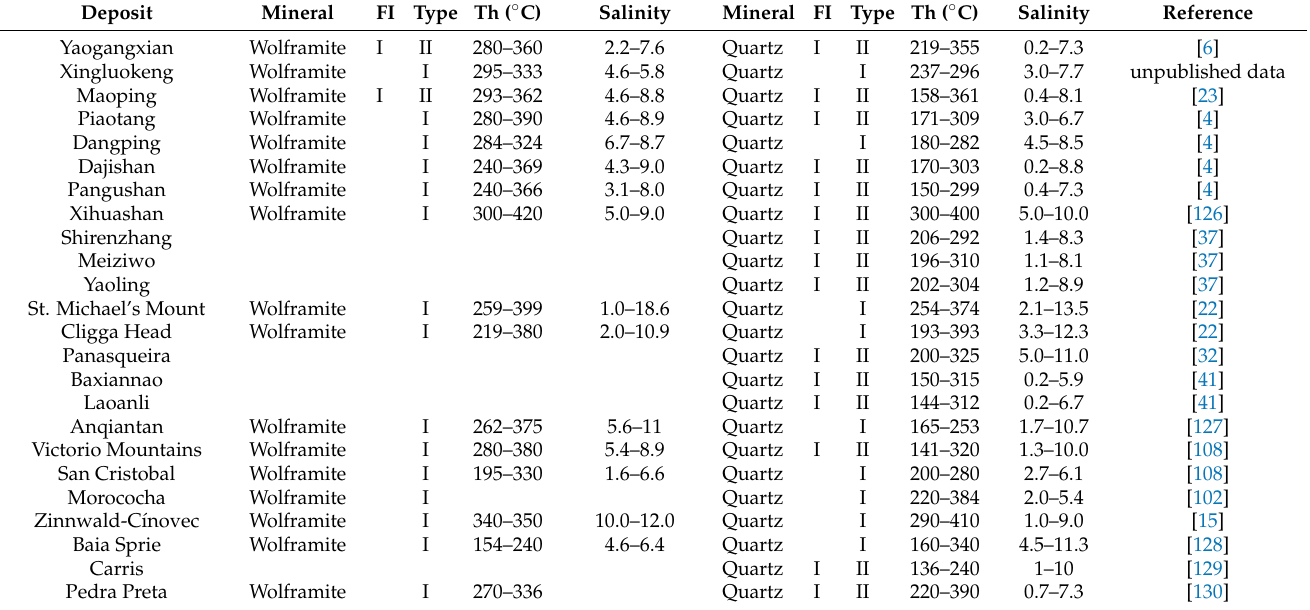
Table 2. Salinity and homogenization temperature data from several wolframite-quartz vein-type